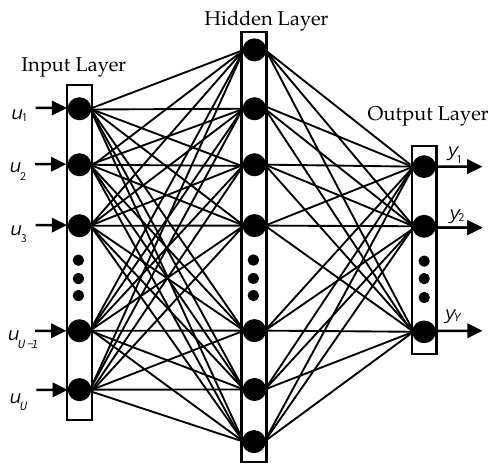
Figure 6. The structure of BPNN.